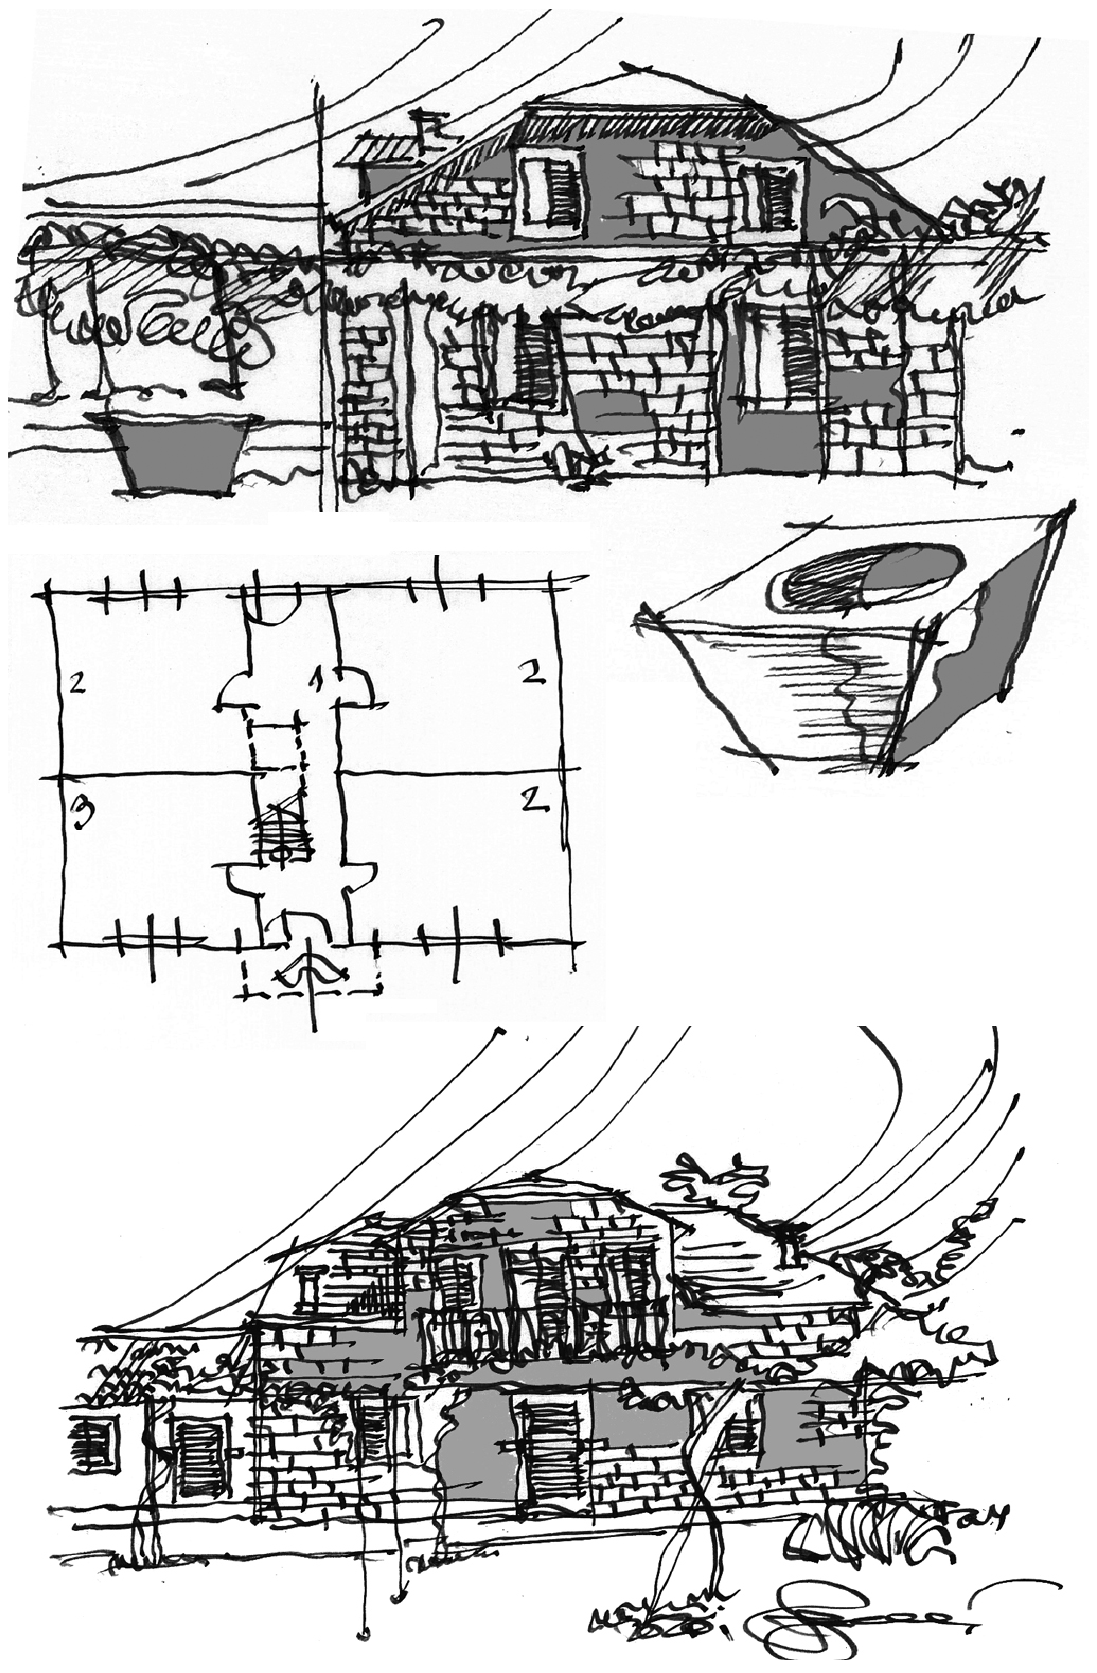
Figure 15. Drawing of the House of Skrobanovic, Zeta region, Montenegro (S. G. Popovic).